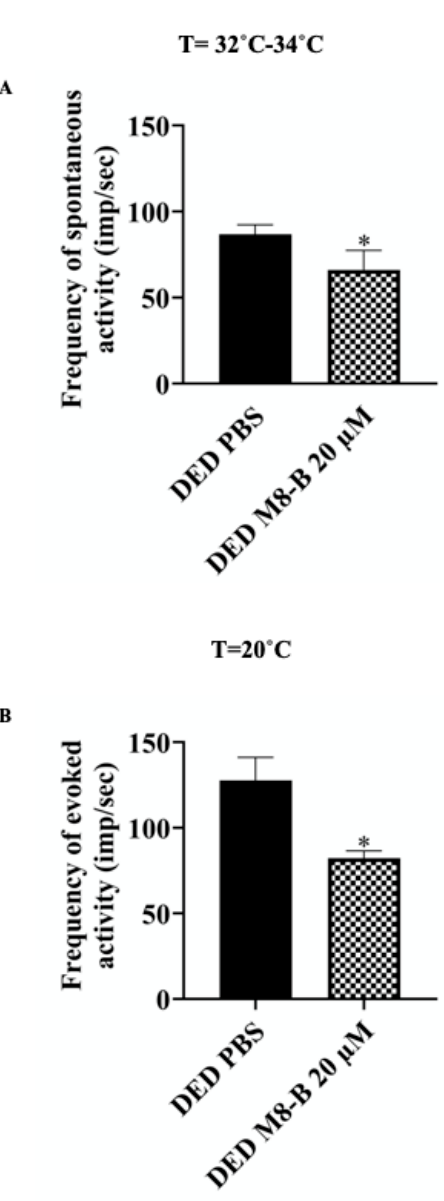
Figure 4. Ex vivo evaluation of spontaneous and evoked activity of ciliary nerve in DED mice treated with 20 µM M8-B or PBS. Histograms show mean value of ( A ) spontaneous activity of ciliary nerve at 32 °C and ( B ) evoked activity of ciliary nerve at 20 °C in DED mice treated with 20 µM M8-B vs. PBS. DED mice treated with 20 µM M8-B vs. PBS ( n = 6). All experiments were conducted at day 21. * p < 0.05 relative to DED mice treated with PBS. Results are expressed as mean ± SEM. For statistical analysis, the Kolmogorov–Smirnov test was performed followed by a parametric t -test using GraphPad Prism version 7.00 (GraphPad Software, La Jolla, CA, USA).